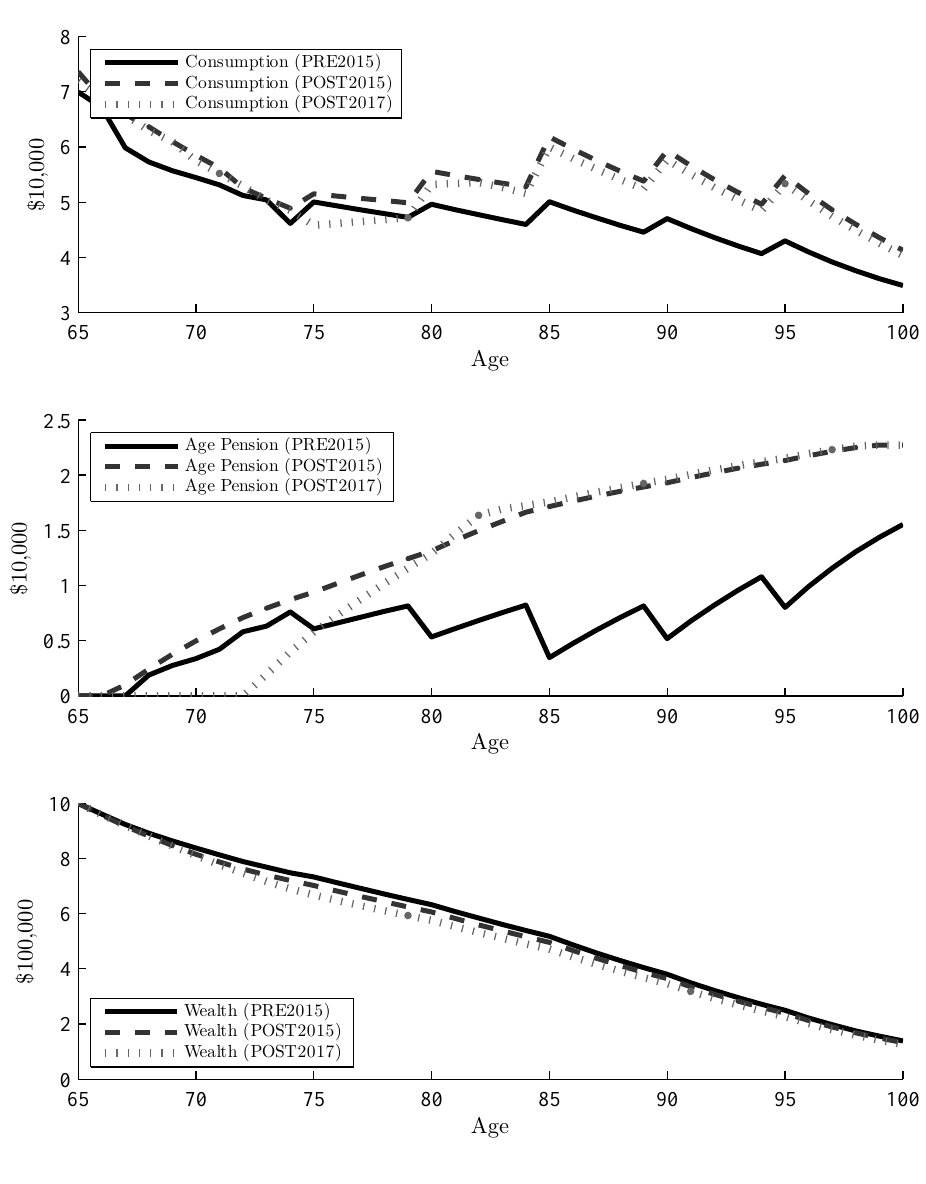
Figure 2. Comparison of consumption, Age Pension and wealth over a retiree’s lifetime with the three different policy scenarios. The retiree starts with $1m liquid wealth, which grows with the low expected return each year ( µ = 0.0325), and drawdown follows the optimal drawdown paths under each